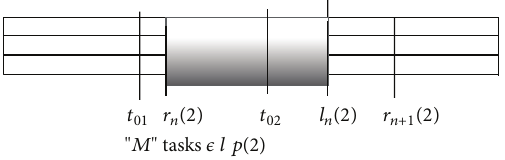
Figure 5: “ M ” tasks ∈ 𝑙𝑝(2) released at 𝑡 ∈ [𝑟 𝑛 (2),𝑡 02 ]